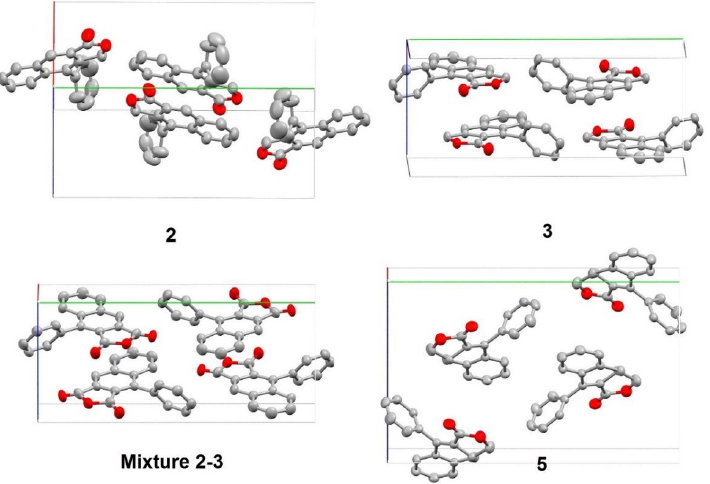
Figure 4. Packing of unit cell view along the a-axis in 2 , 3 , mixture 2 – 3 and 5 . All H atoms are omitted for clarity.